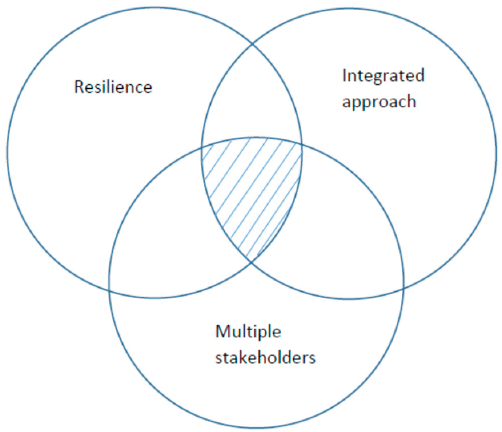
Figure 3. Outline of concept chart for improved urban flood resilience followed in this paper. The marked area in the middle of the chart denotes sustainable stormwater management solutions.